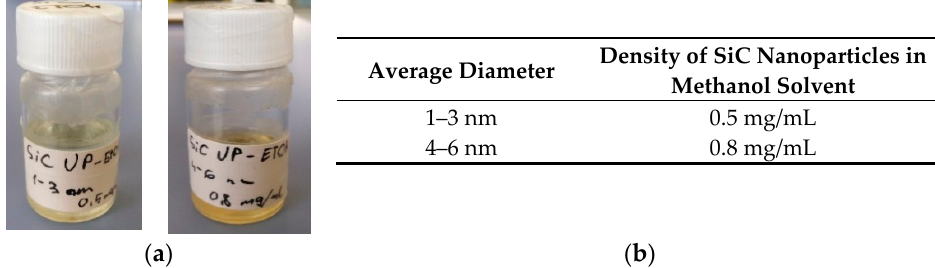
Figure 4. ( a ) Colloidal silicon-carbide nanocrystals (SiC-NCs) dispersed in methanol, and ( b ) specifics of the liquid solution.